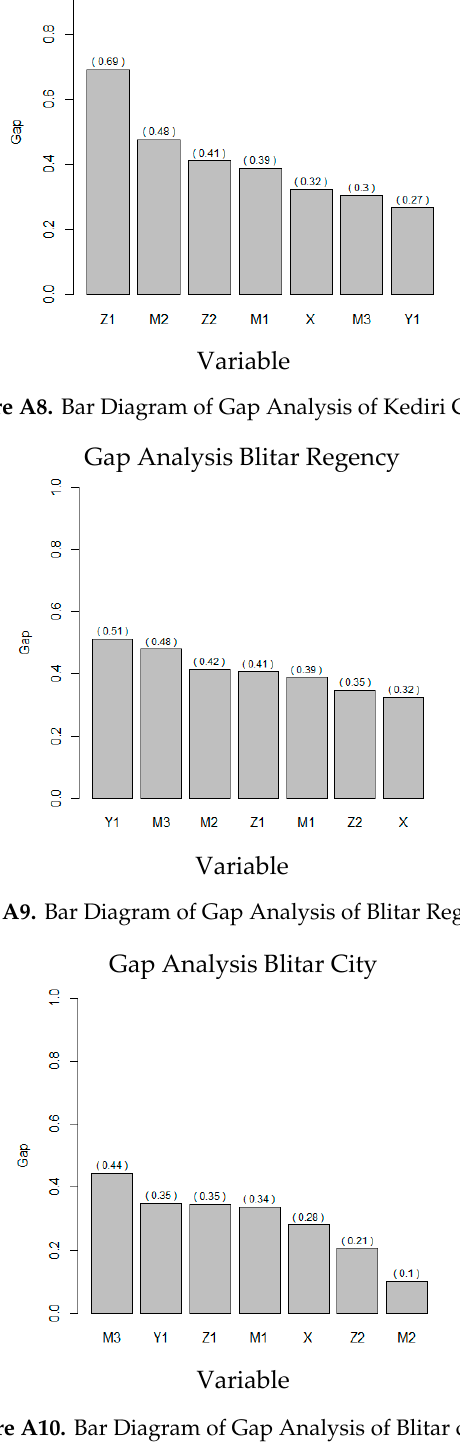
Figure A10. Bar Diagram of Gap Analysis of Blitar city.